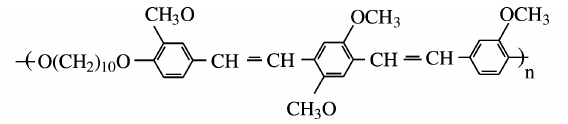
Figure 1. Structure of the alternating block copolymer used in this work, in poly(1,10-decanedioxy-2-methoxy-1,4-phenylene-1,2-ethenylene-3,6- dimethoxy-1,4-phenylene-1,2-ethenylene-3-methoxy-1,4-phenylene), OPPVDBC. Figure 2. Absorption spectrum of